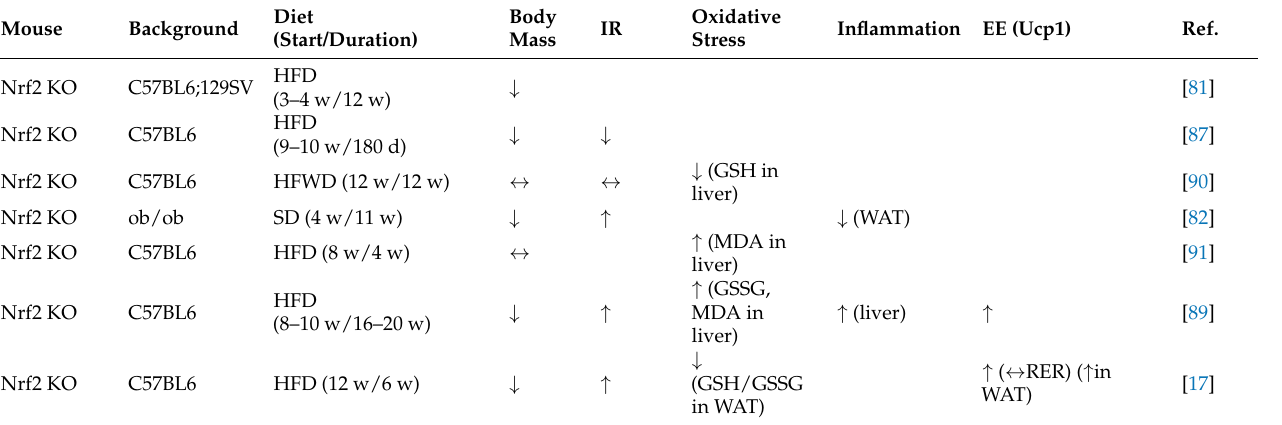
Table 1. The effects of Nrf2 inhibition in energy